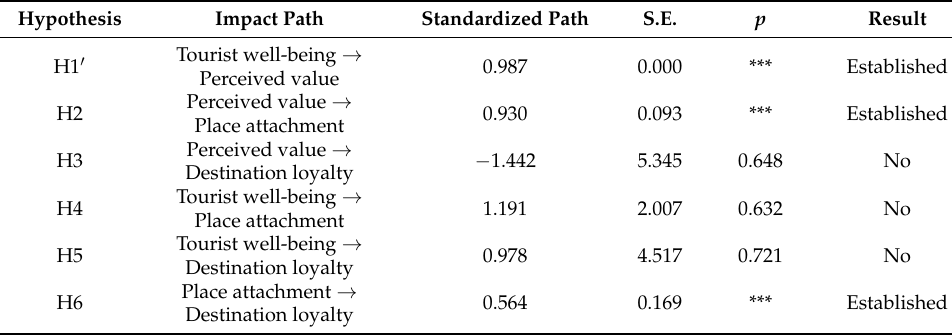
Table 6. Validation analysis results of model M 2 .